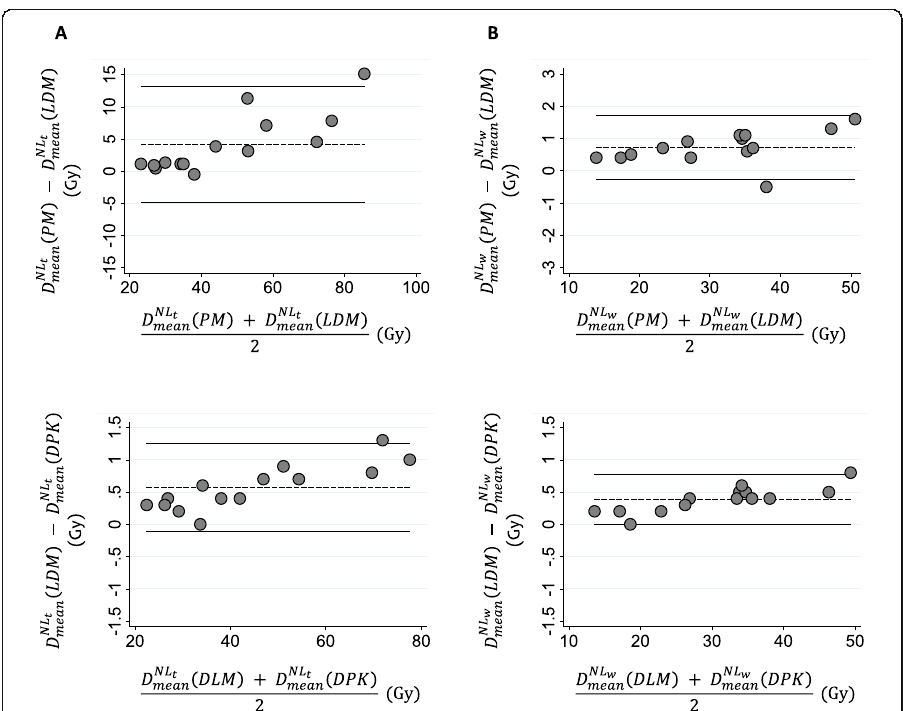
Fig. 3 Bland-Altman diagrams representing the relative dose difference in Gy between dosimetry methods versus the mean absorbed dose values in Gy for both normal target liver a and whole normal liver b . The dashed line represents the average of the differences between the studied dosimetry methods, and the black line is the mean differences of ± 2 SD